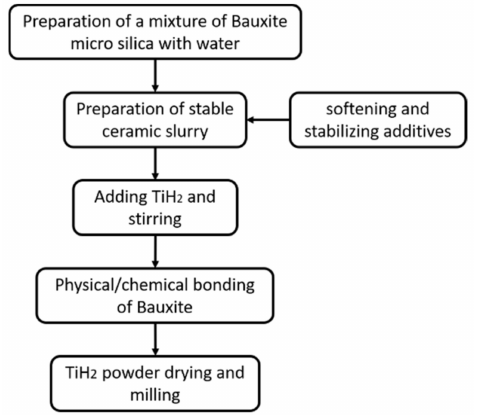
Figure 2. Preparation steps of TiH 2 embedded with